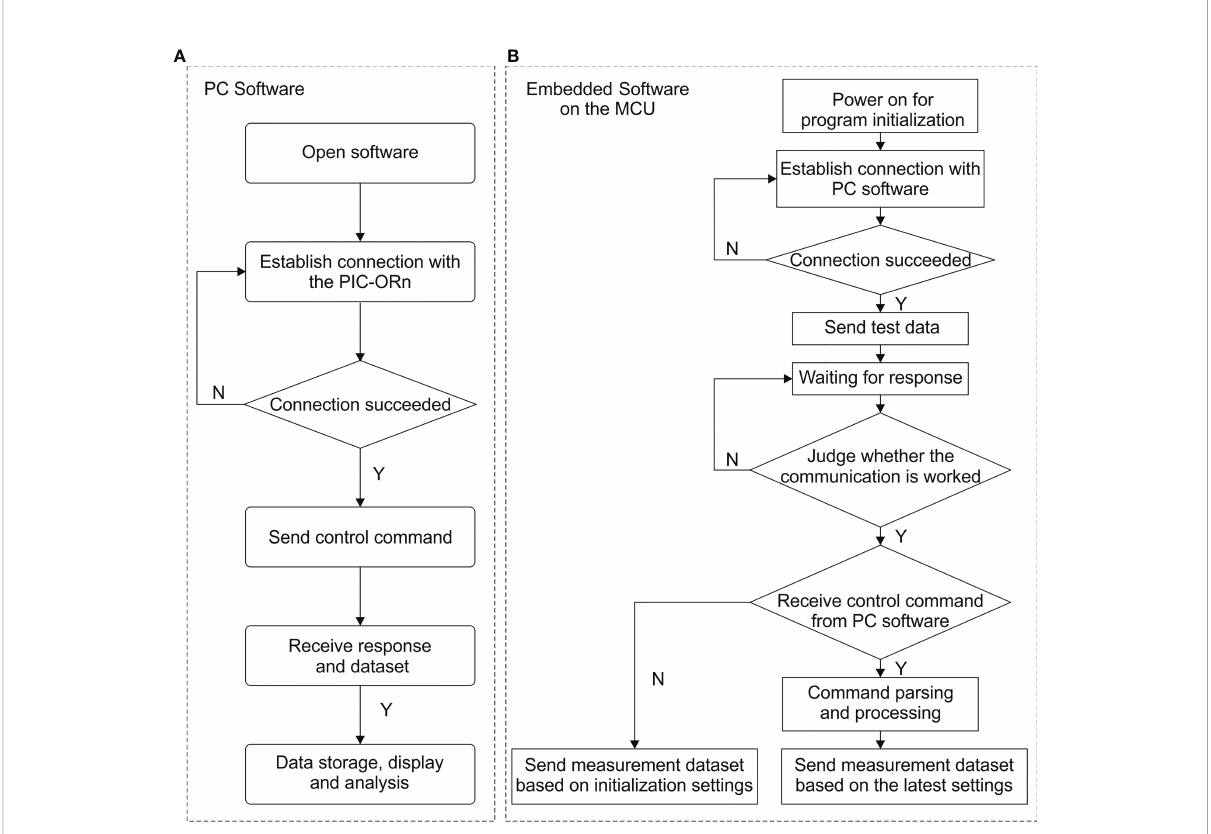
FIGURE 3 Control fl ow charts of the PC Software (A) and Embedded Software on the MCU (B) ,